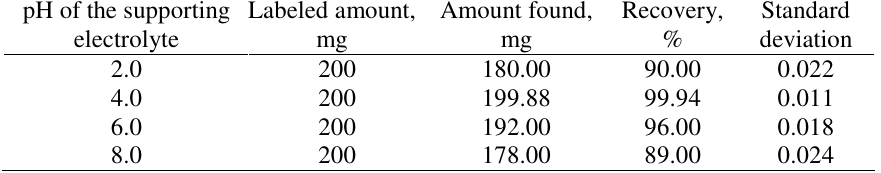
Table 3. Assay of zileuton by DPP in pharmaceutical formulations. Pulse amplitude: 50 mV, Drop time: 2